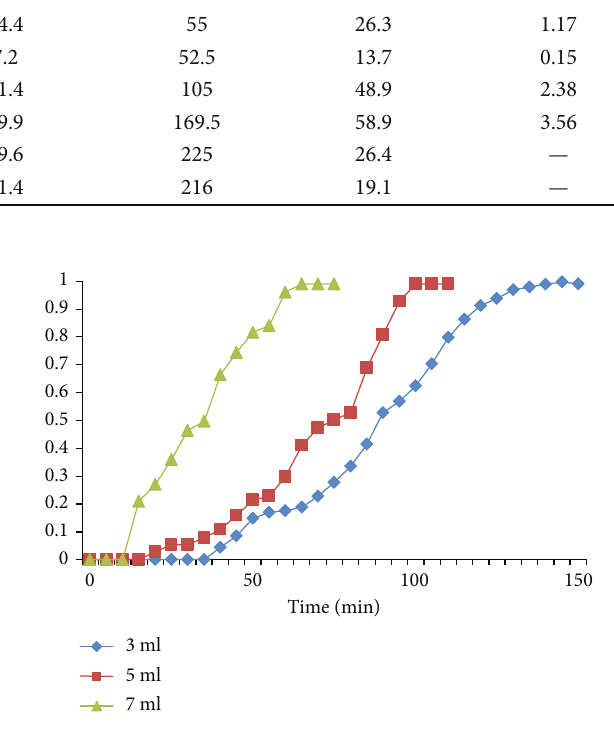
Figure 5: Breakthrough curves of variation of fl ow